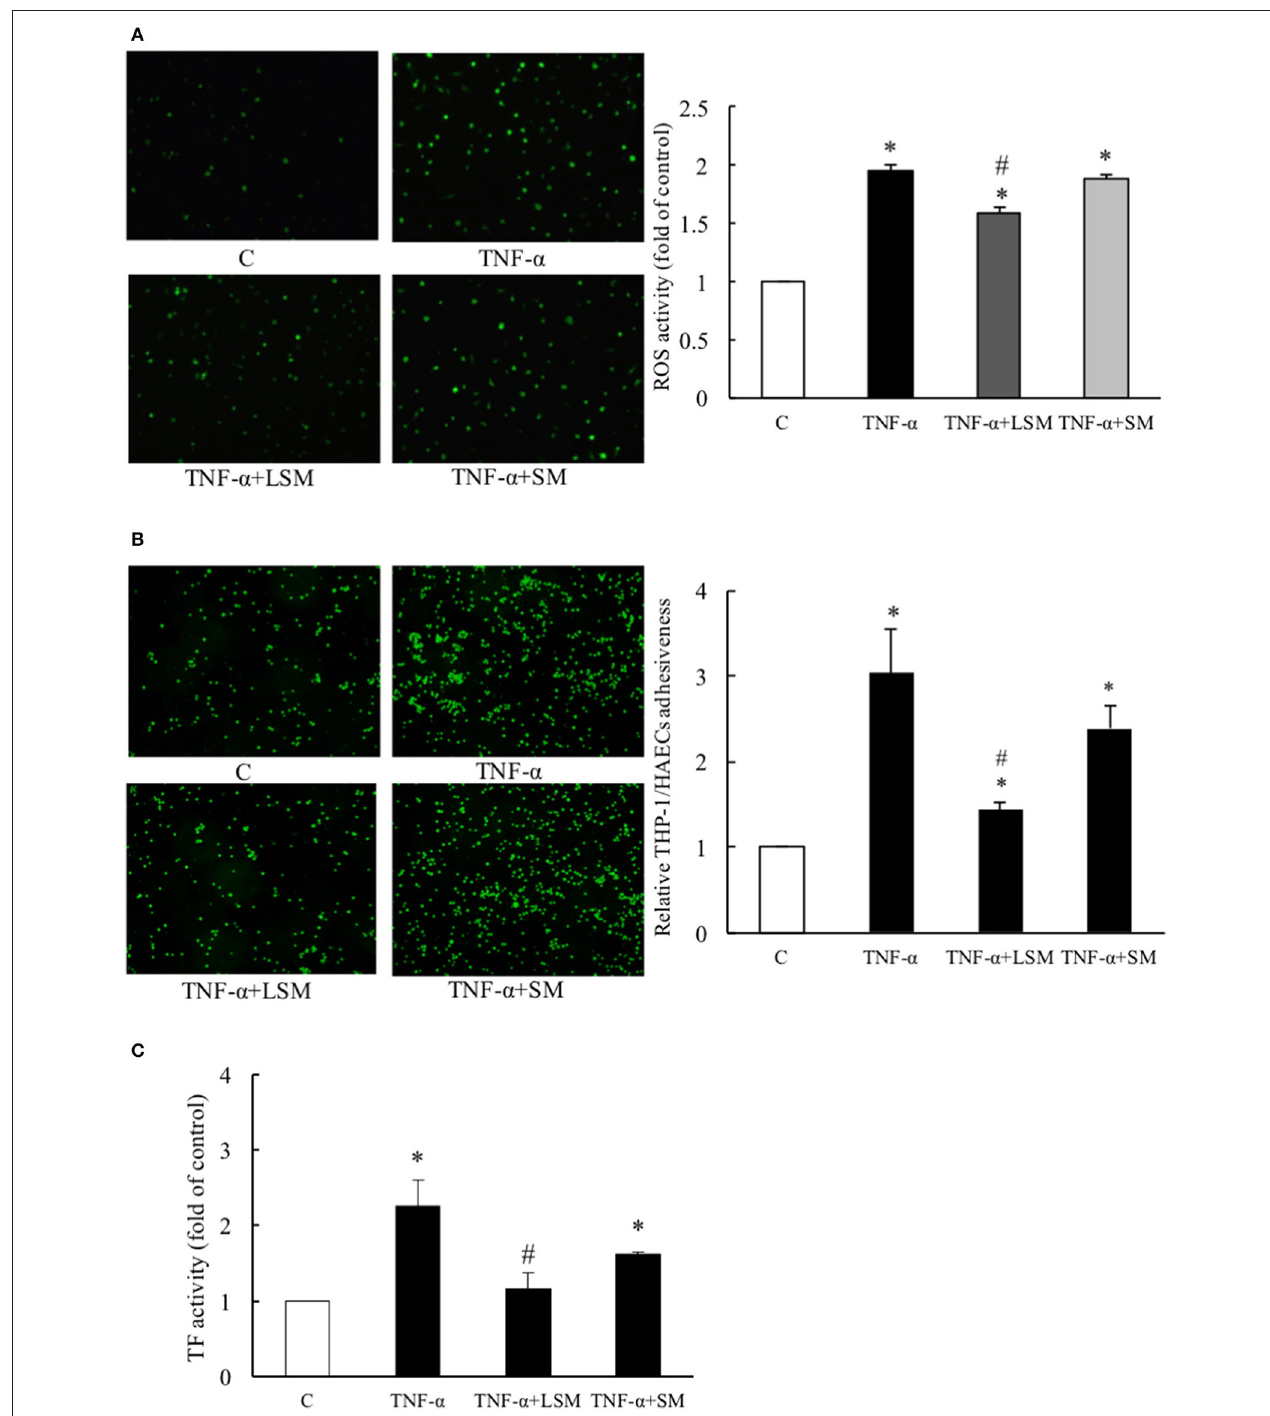
FIGURE 2 | Evaluation of protective efficacies of LSM and SM on TNF- α -induced ROS activity, inflammation, and thrombosis. (A) TNF- α group showed significantly intensified H 2 DCFDA dependent fluorescence (average 1.95-fold) compared to in the control group. The TNF- α + LSM group showed significantly attenuated expression (average 1.59-fold) compared to in the control group. (B) TNF- α group showed significantly higher (average 3.04-fold) THP-1/HAECs adhesiveness than the control group. The TNF- α + LSM group was significantly attenuated (average 1.44-fold) compared to the control group. (A,B) Data are expressed as the mean ± S.E.M. ( n = 4). * p < 0.05 indicates a significant difference relative to the control group. # p < 0.05 indicates a significant downregulation relative to the individual TNF- α group. (C) TF activity was significantly induced (average 2.26-fold) in the TNF- α group and attenuated significantly (average 1.16-fold) in the TNF- α + LSM group compared to that in the TNF- α group. Data are expressed as the mean ± S.E.M. ( n = 3). * p < 0.05 indicates a significant difference relative to the control group. # p < 0.05 indicates a significant downregulation relative to the individual TNF- α group. SM, static medium. LSM, new laminar shear medium.